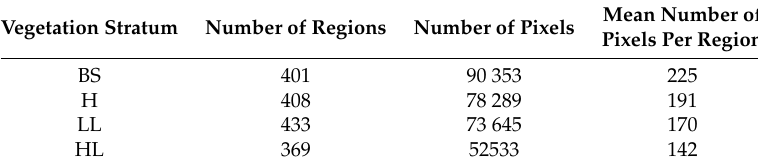
Table A1. Number of samples regions per vegetation stratum. BS: bare soil; H: herbs; LL: Low ligneous; HL: High